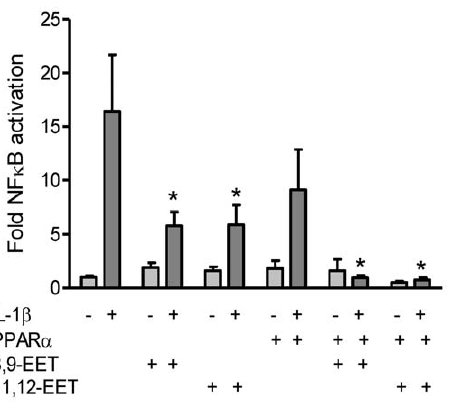
Figure 2. Epoxygenase products inhibit NF k B activation through PPAR a -dependent manner and independent path- ways. Exogenous EETs inhibit IL-1 b -induced NF k B independently of PPAR a , HEK293 cells were transfected with a NF k B-luciferase reporter gene with either an expression plasmid for PPAR a , or control empty plasmid (pcDNA3.1). 8,9-EET and 11,12-EET (1 m M) inhibit IL-1 b induced NF k B reporter gene in the presence and absence of co-transfected PPAR a . *denotes p , 0.05 between IL-1 b and treatments, by one-way ANOVA and Bonferroni’s post test. Data represents mean 6 SEM of n=9 determinations from 3 separate experiments. (EPOME) (9,10-dihydroxy-octadecenoic acid, 213.5 6 111.8 pg/ ml) over 24 h. CYP2J2, CYP2C8 or CYP2C9 transcripts were not